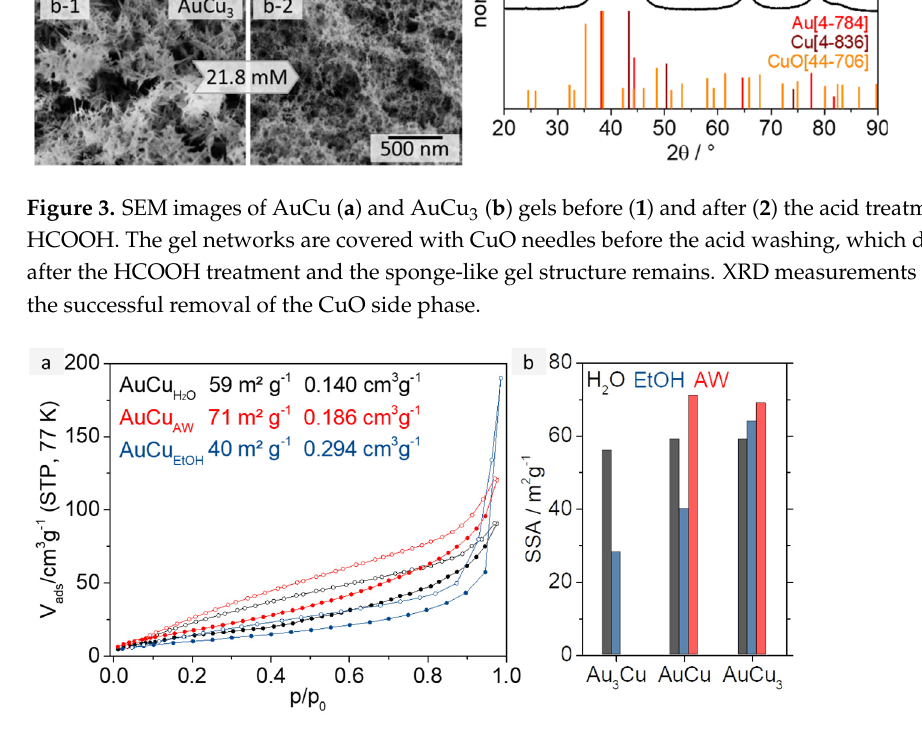
Figure 4. ( a ) N 2 physisorption isotherms of Au x Cu y aerogels synthesized in water (black), after acid treatment with HCOOH (red), and synthesized in EtOH (blue). All samples show typical mixtures of type II and IV isotherm, indicating a broad pore size distribution. ( b ) Specific surface areas for all Au x Cu y aerogels depending on their compositions and the solvent they were synthesized in.